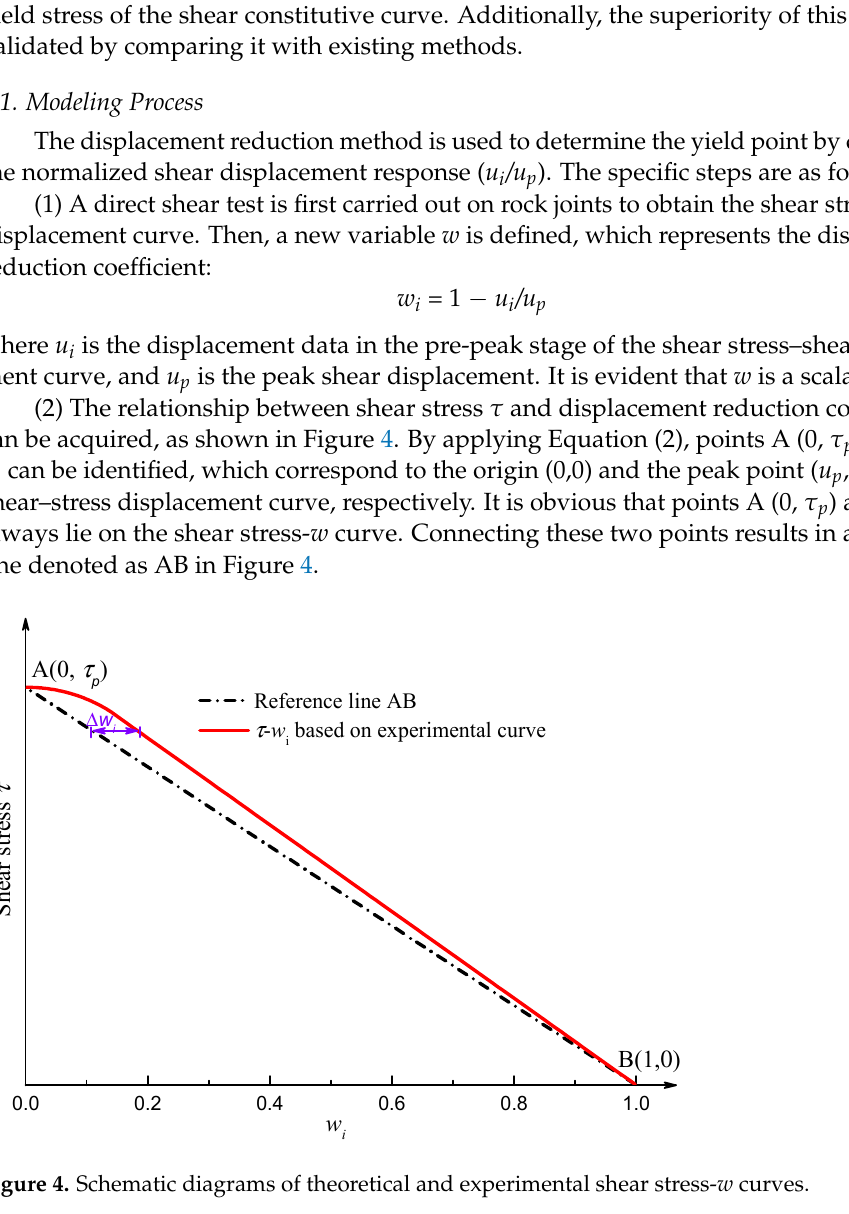
Figure 4. Schematic diagrams of theoretical and experimental shear stress- w curves. (3) Consequently, the difference ∆ w between the experimental shear–stress displace- ment curve and the reference line AB can be calculated, as plotted in Figure 5. During the linearly elastic stage (stage I), ∆ w increases proportionally with the increase in shear stress τ . In contrast, during the yield stage (stage II), the shear displacement exhibits non-linear characteristics. Hence, the yield point is the cut-off point between the linearly elastic stage (stage I) and the yield stage (stage II), where ∆ w reaches the maximum value. Consequently, this method enables easy identification of the yield point while ensuring accuracy and objectivity and eliminating human interference. This method provides a scientific and efficient means of determining the shear yield stress of rock